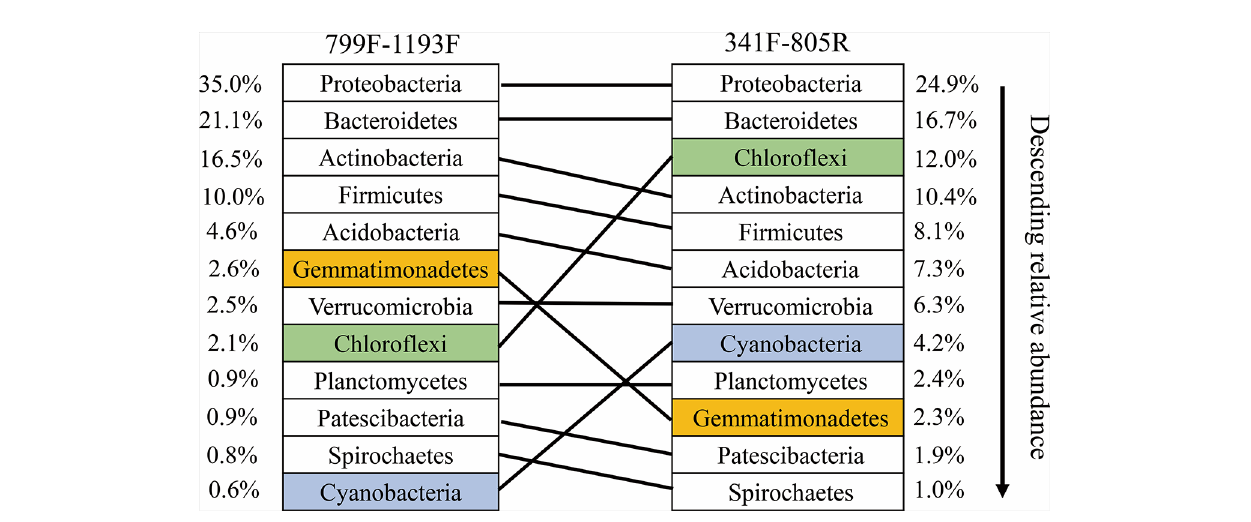
FIGURE 5 | Ranked relative abundant of the top-12 dominant bacterial phyla as determined by the primer pairs 799F/1193F and 341F/805R, respectively. The same phylum ampli fi ed by the two primer pairs are linked by line.